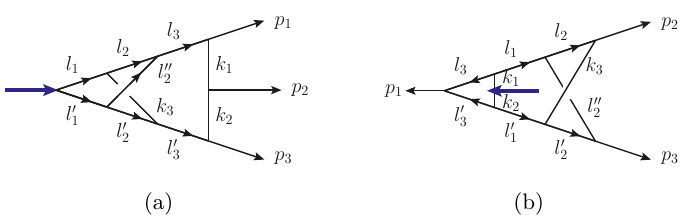
Figure 2. Example diagrams for diagrammatic symmetry constraints. The color factor C a of (a) is proportional to ˜ f a 1 a 2 a 3 and non-vanishing while the color factor C